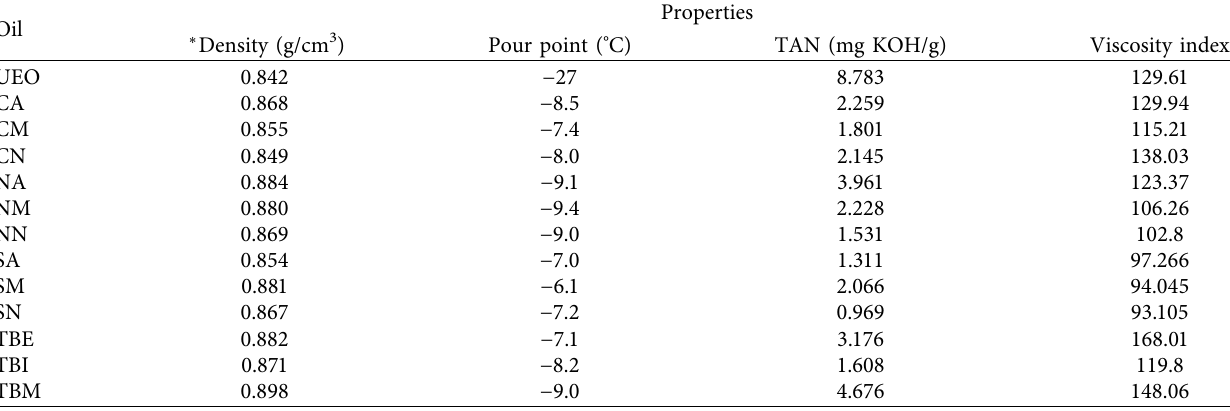
Table 2: Properties of the used engine oil and re-refned oils from this work.